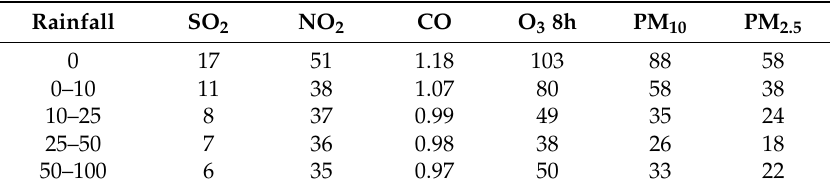
Table 5. Air pollutant concentrations based on rainfall classification in Shenzhen from March 2013 to February 2014 (mg/m 3 for CO, µ g/m 3 for